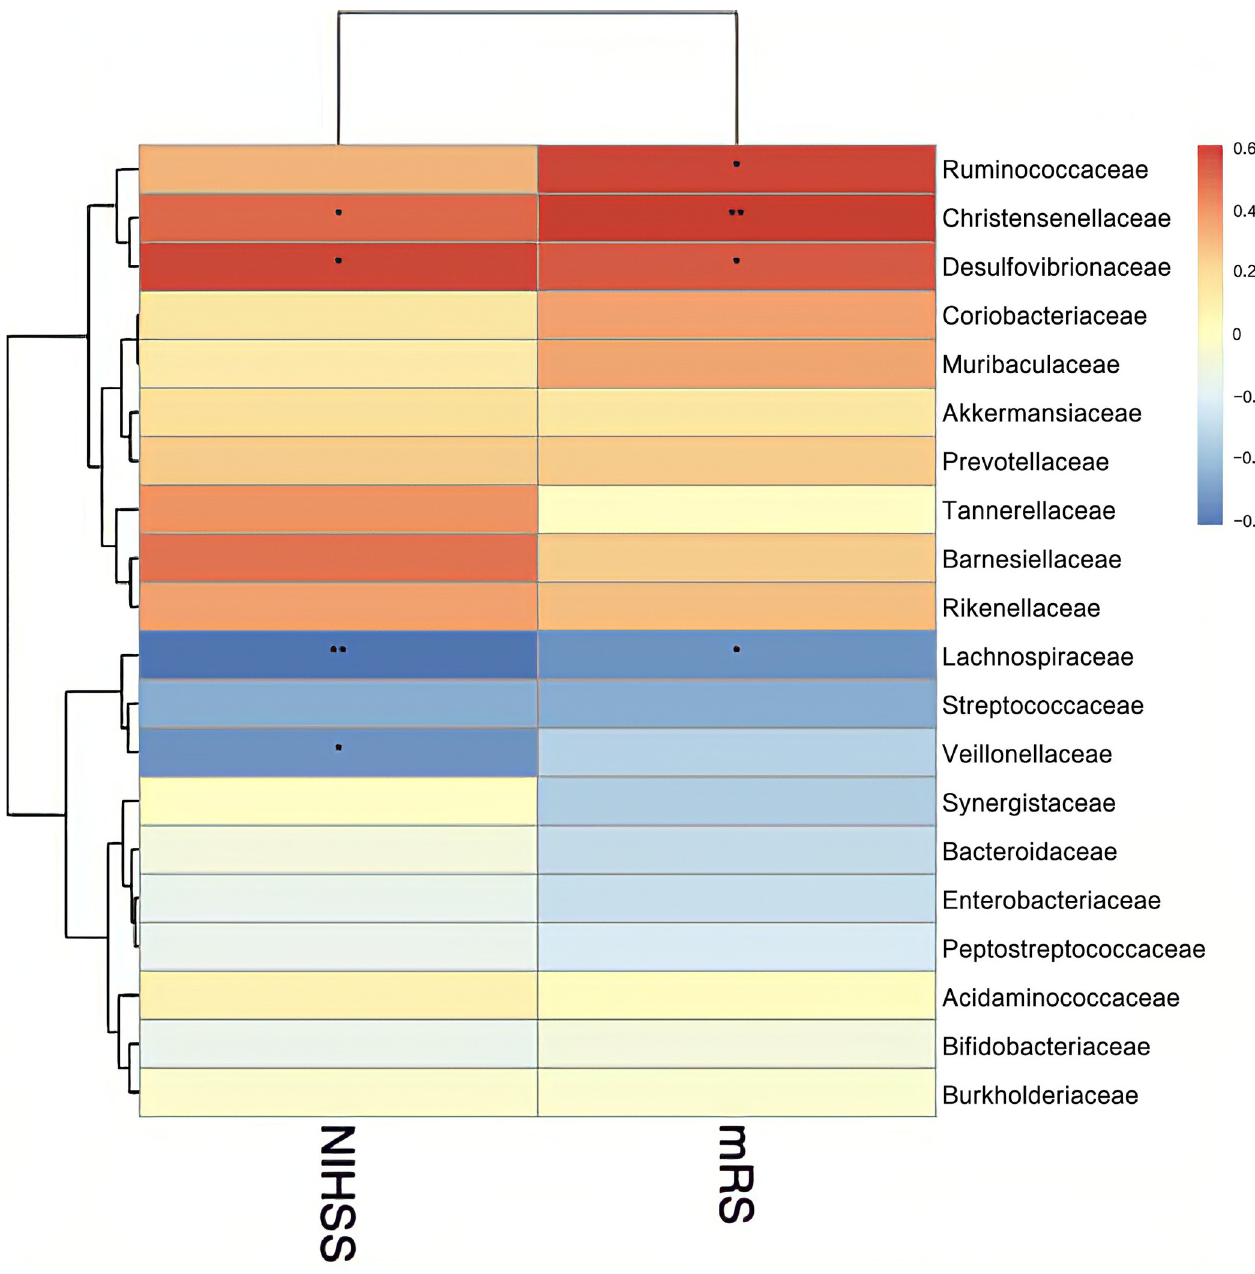
Fig 11. Heatmap of the Spearman correlation coefficients between the gut microbiota at the family level and severity of stroke measured by NIHSS and mRS scores at admission. � P < 0.05, �� P < 0.01. NIHSS: National Institutes of Health Stroke Scale, mRS: Modified Rankin Scale.